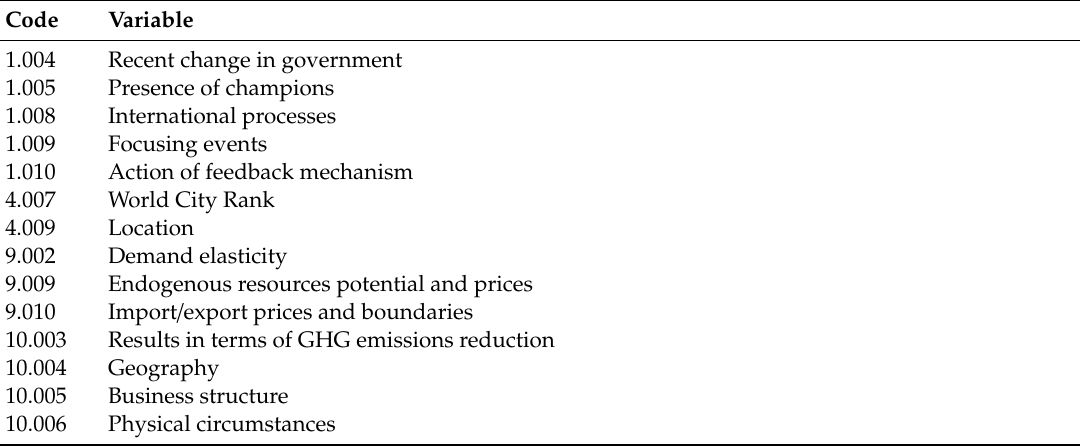
Table A2. Variables excluded for non-applicability in the systematic literature review